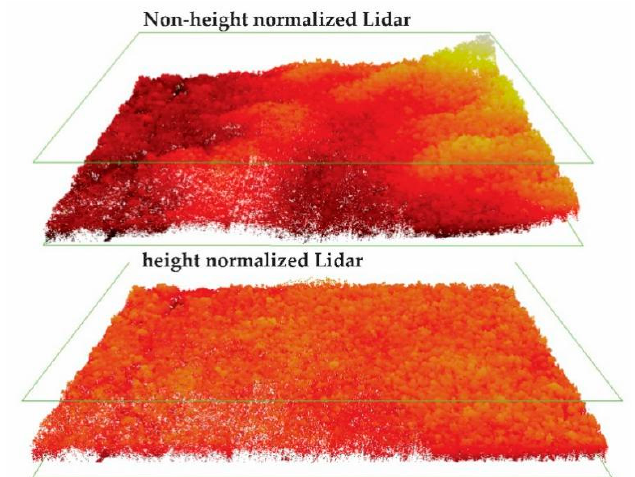
Figure 3. The di ff erences between the non-height normalized lidar ( top figure ) and the height Figure 3. The differences between the non-height normalized lidar ( top figure ) and the height normalized lidar ( bottom figure ); color represents elevation. normalized lidar ( bottom figure ); color represents elevation.